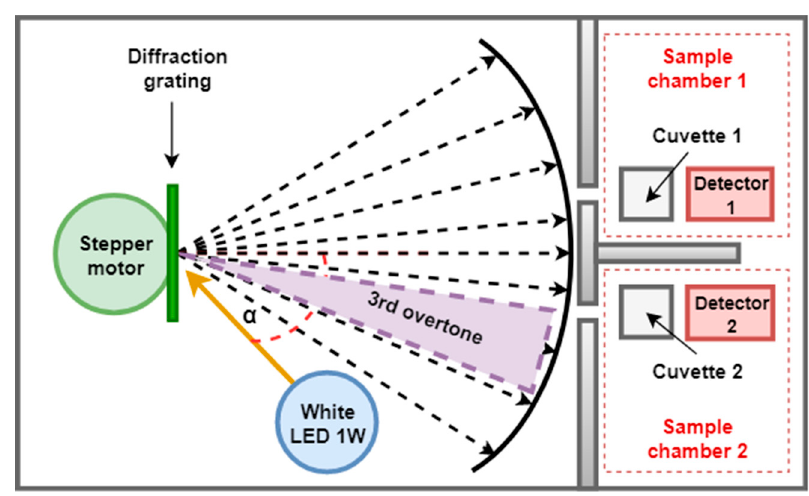
Figure 2. Selected overtone produced by the diffraction grating.